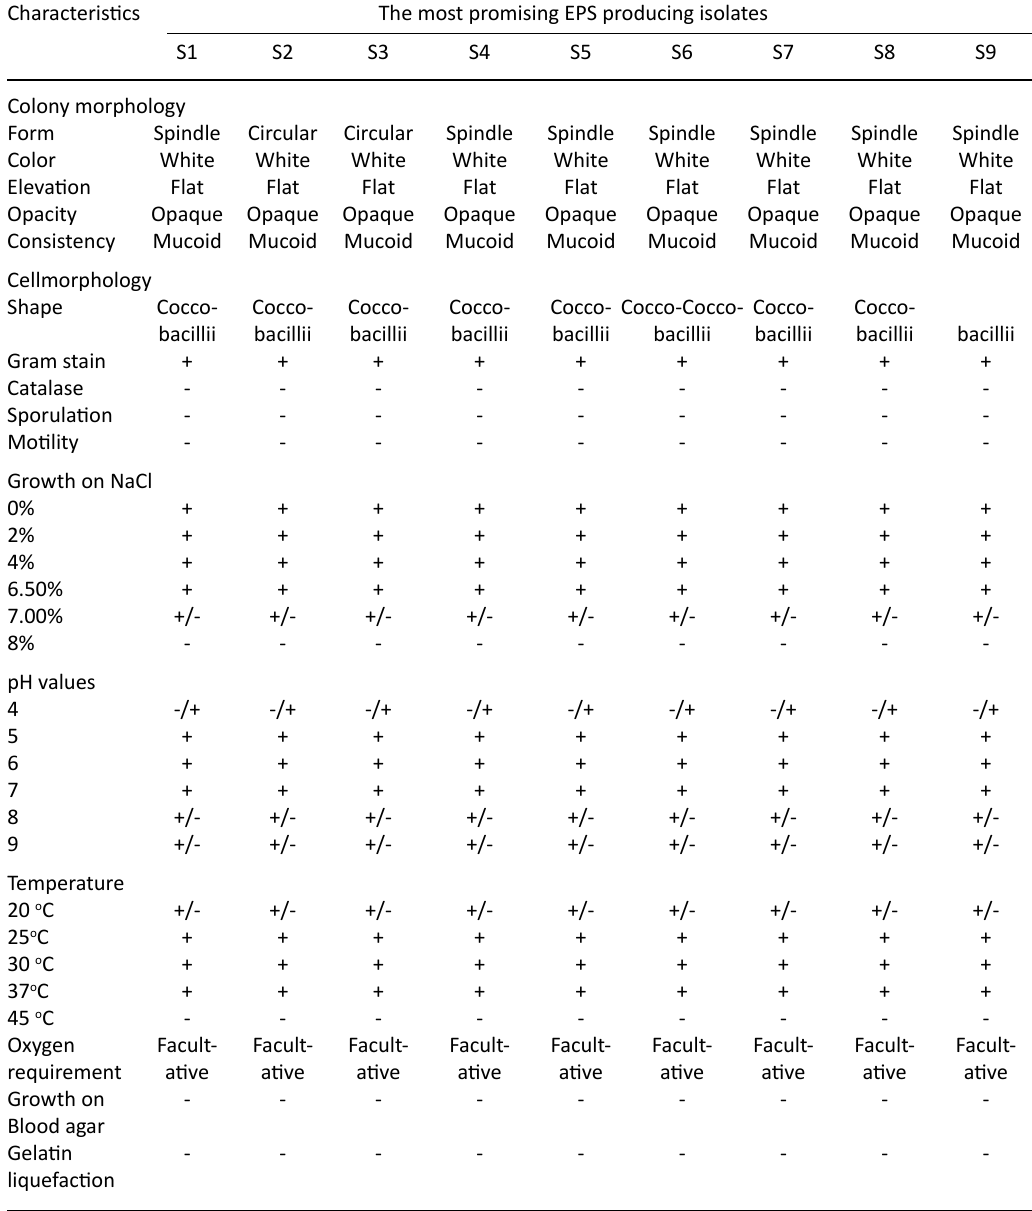
Table 2. Morphological andpartial characterization ofthe most promising EPS producing isolates